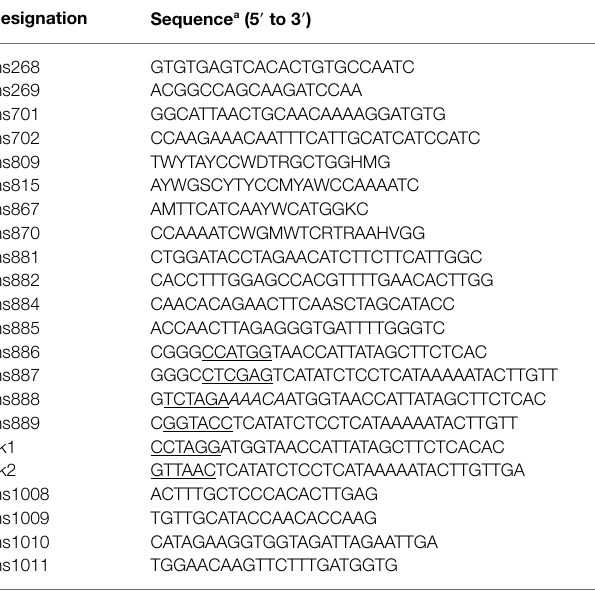
TABLE 1 | Oligo nucleotide primers used in this